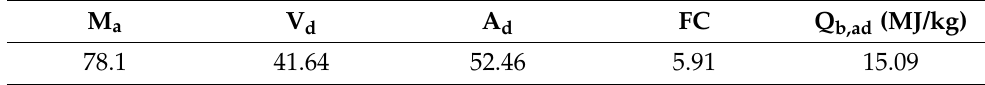
Table 1. Proximate analysis of sewage sludge (wt.%).